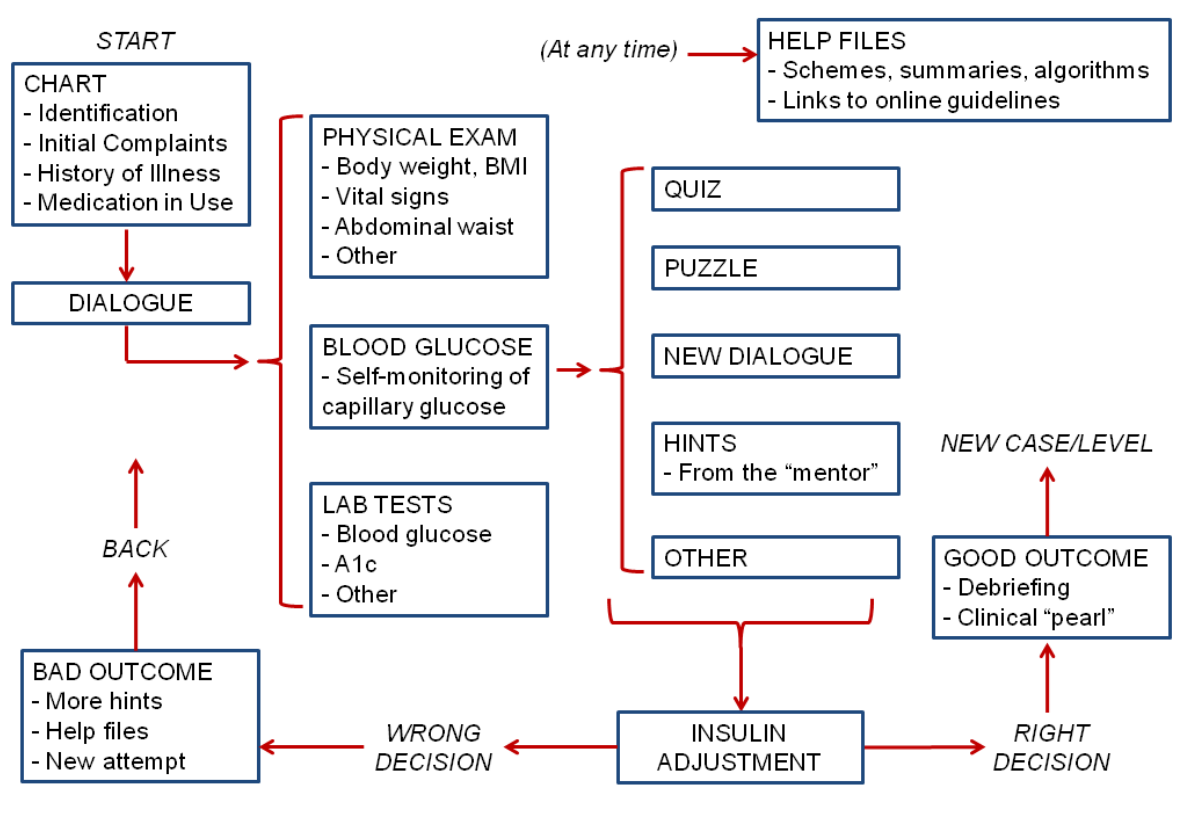
Figure 1. Basic structure of an InsuOnline